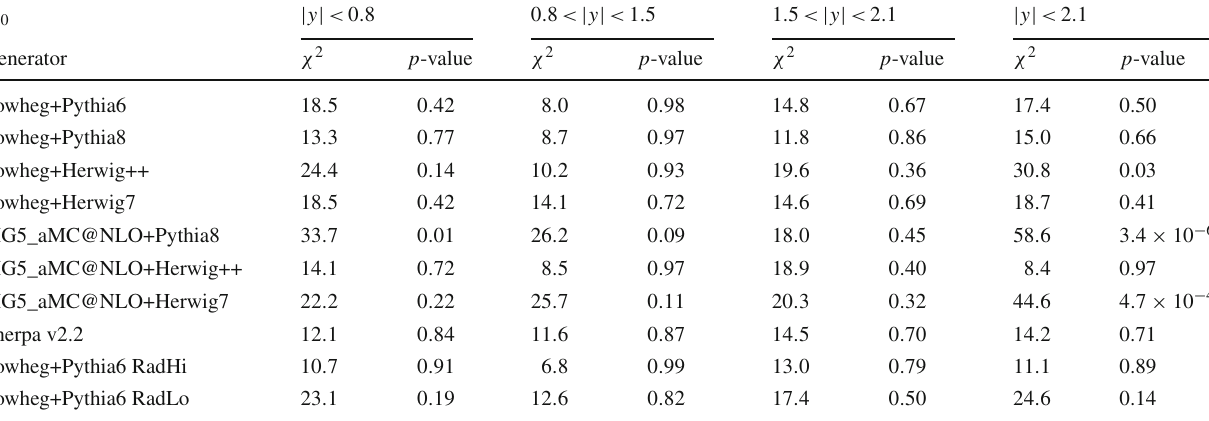
Table 12 Values of χ 2 for the comparison of the measured gap fraction distributions with the predictions from various t ¯ t generator configurations, for the four rapidity regions as a function of Q 0 . The χ 2 and p -values correspond to 18 degrees of